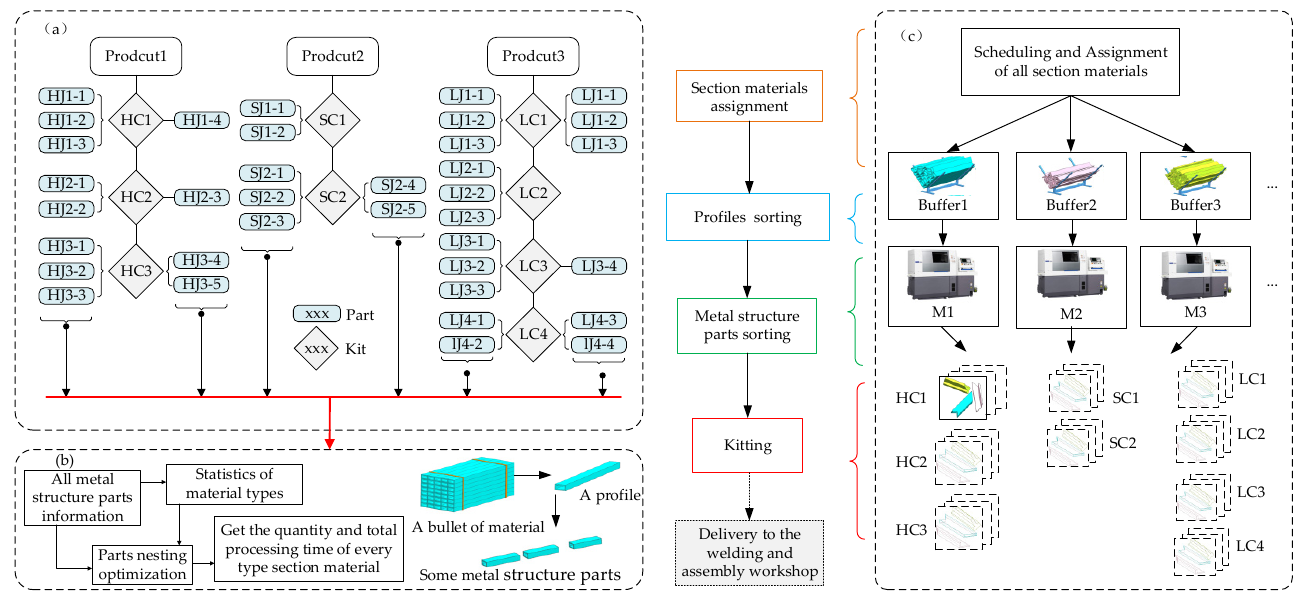
Figure 1. The product structure and production scheduling process of metal structural parts. ( a ) The schematic diagram of product structure of metal structural parts; ( b ) statistics of material and part nesting; ( c ) the production scheduling process.